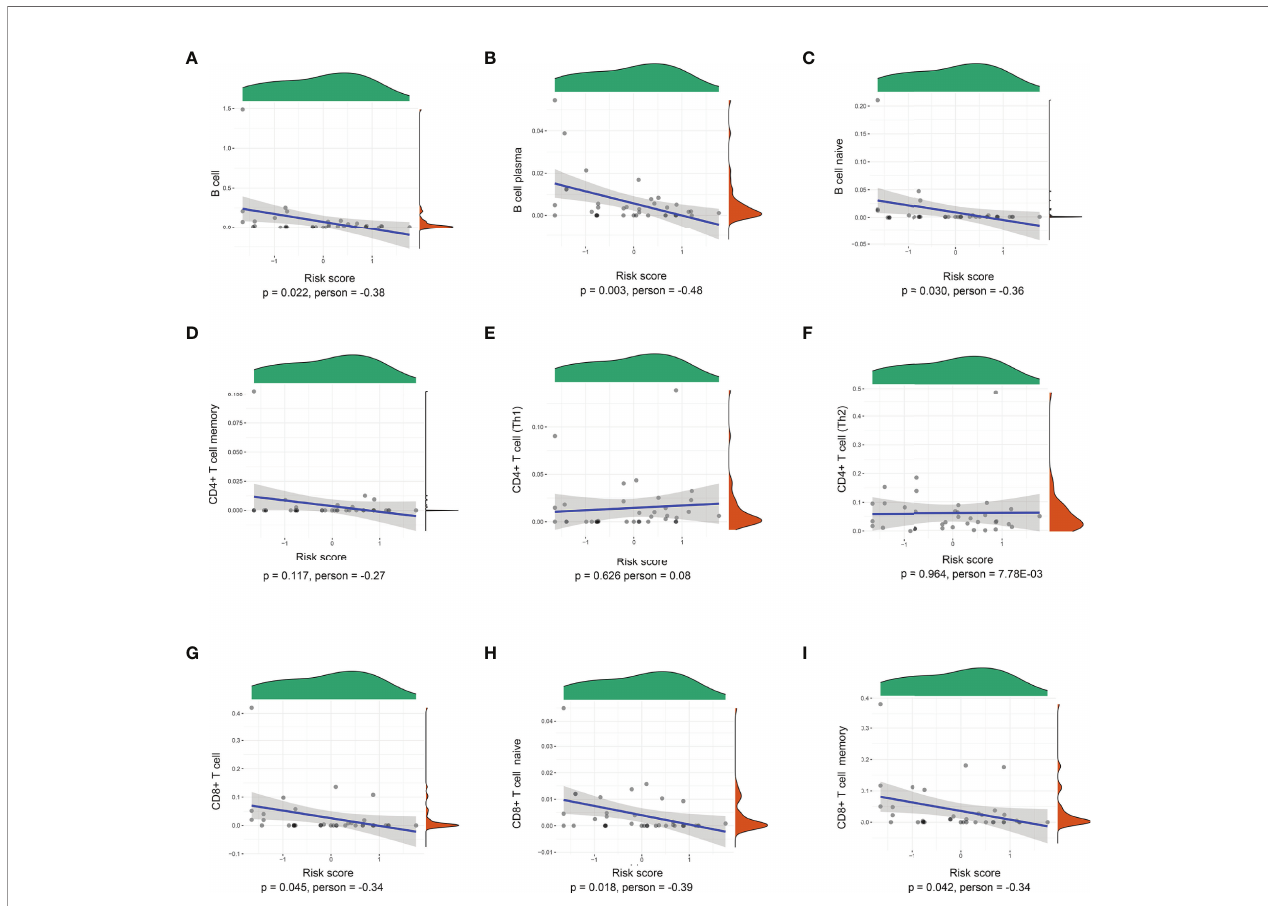
FIGURE 3 | Correlations between the prognostic signature-derived risk score and in fi ltration abundances of multiple immune cells. (A) B cells, (B) B-cell plasma, (C) B-cell naïve, (D) CD4+ T-cell memory, (E) CD4+ T cell (Th1), (F) CD4+ T cell (Th2), (G) CD8+ T cell, (H) CD8+ T-cell naïve, and (I) CD8+ T-cell memory (Pearson correlation